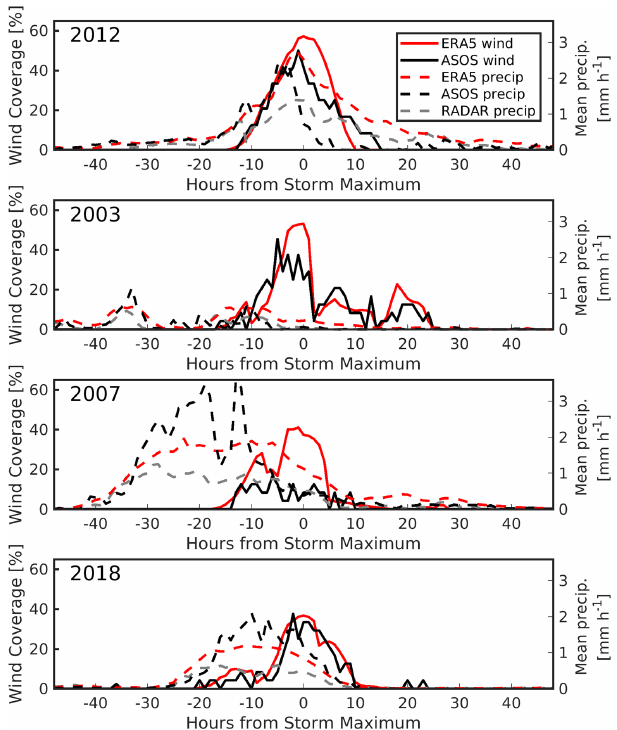
Figure 6. Time series of high wind coverage and mean precipitation rate during the four windstorms that occurred after the year 2000. Each subplot includes the fraction of ERA5 grid cells with over- threshold wind speeds ( U>U 999 ); the number of ASOS stations with over-threshold wind speeds; and the mean precipitation rate (in land areas of Northeast states within 200km of a radar station) from ERA5, NWS radar, and ASOS point